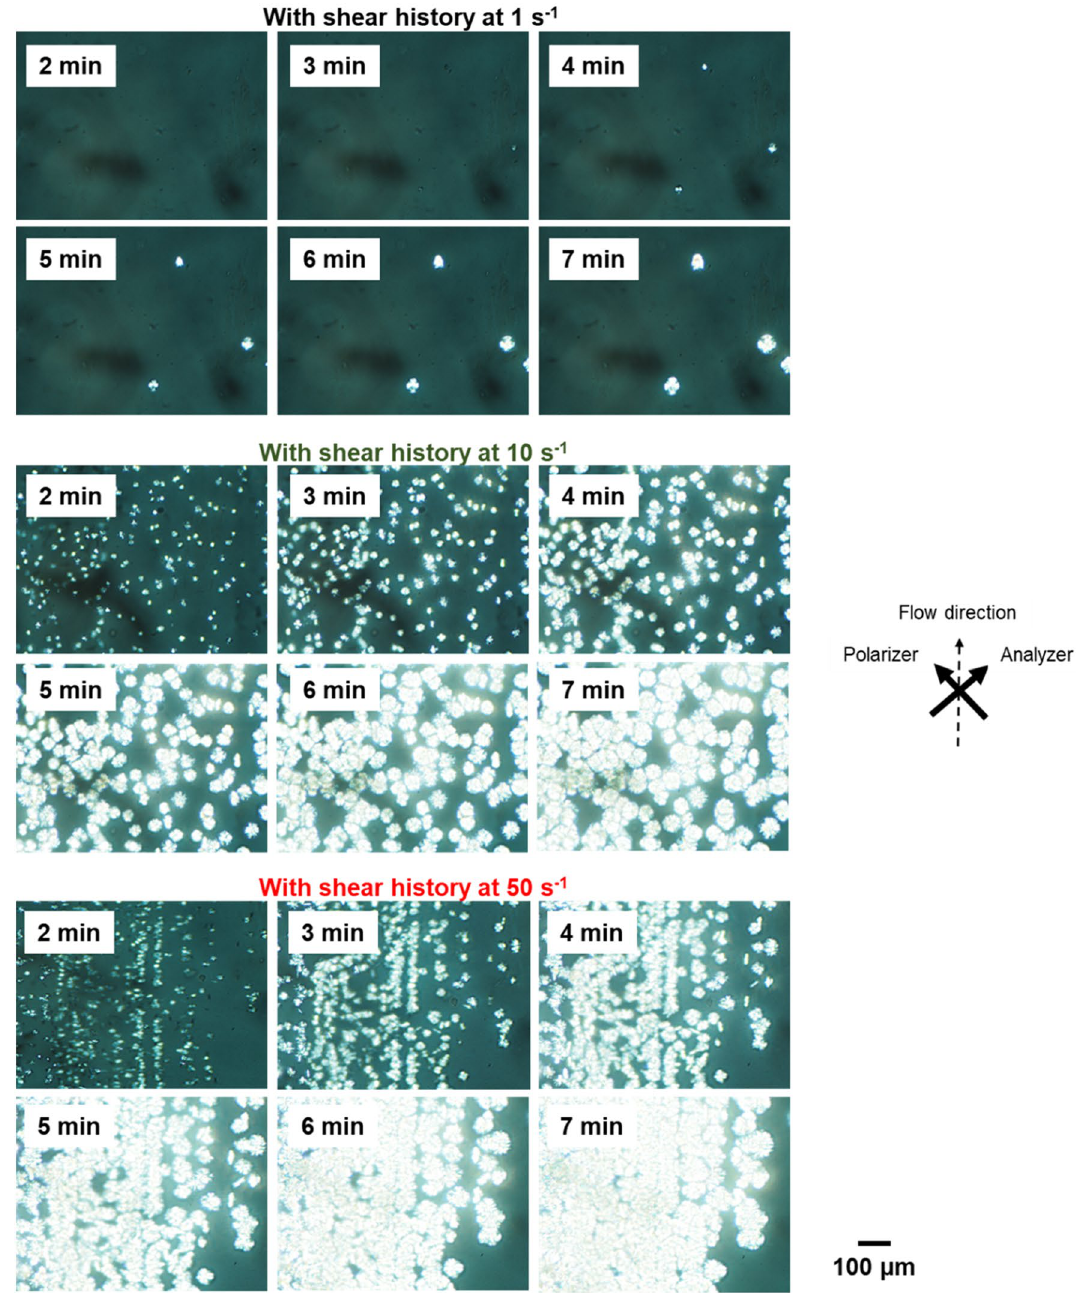
Figure 10. Polarizing optical microscope (POM) images showing the morphology during the isothermal process with applied shear history during cooling at 10 °C min −1 . The shear history was applied from 180 to 110 °C at 1, 10, and 50 s −1 , then held at 110 °C for 10